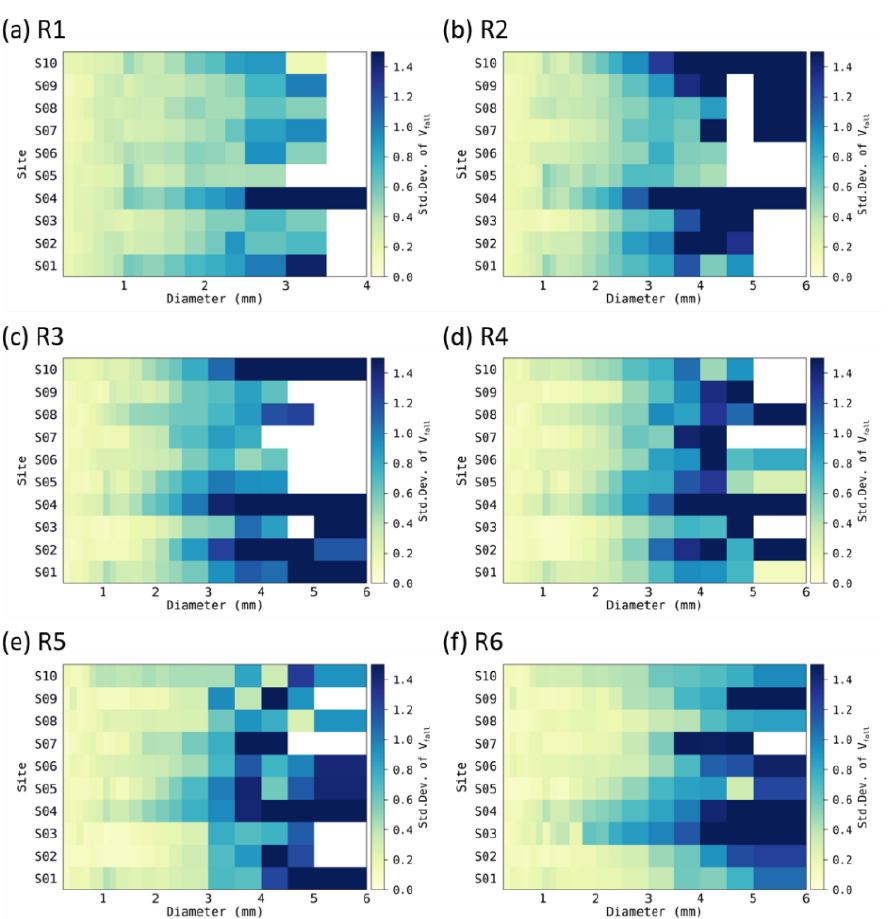
Figure 5. The standard deviation of the fall velocity of raindrops for rain rate categories at the 10 Parsivel sites.